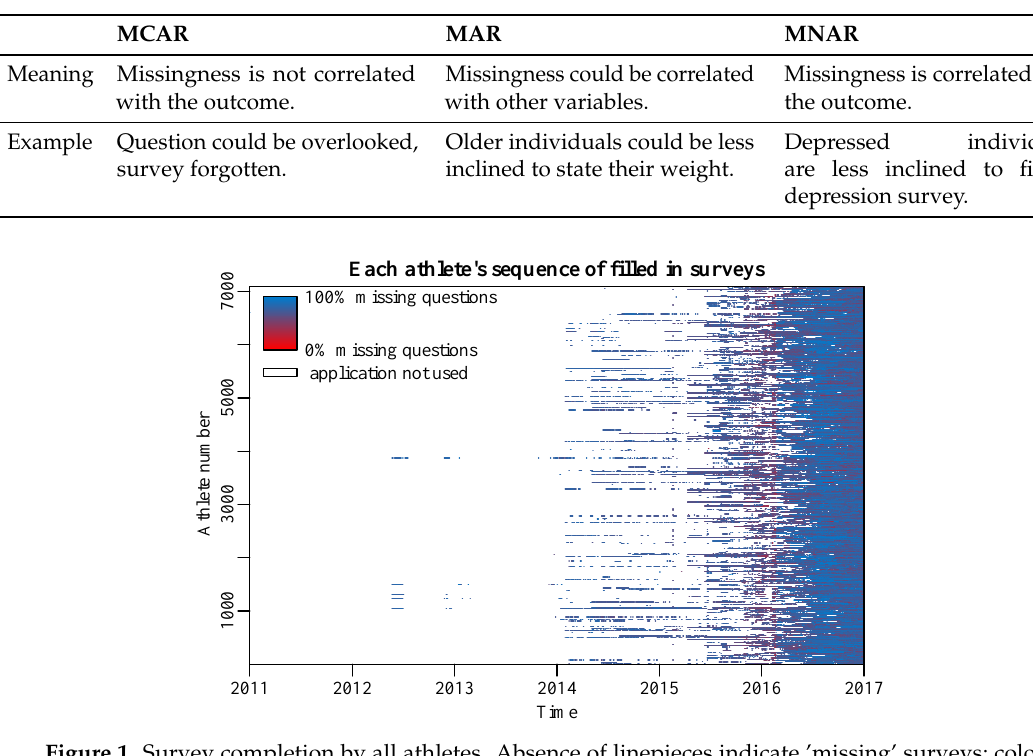
Figure 1. Survey completion by all athletes. Absence of linepieces indicate ’missing’ surveys; color indicates the amount of missingness within surveys. There are filled in surveys throughout the entire sequence, although usage in 2011–2012 is so sparse that it appears as though there are